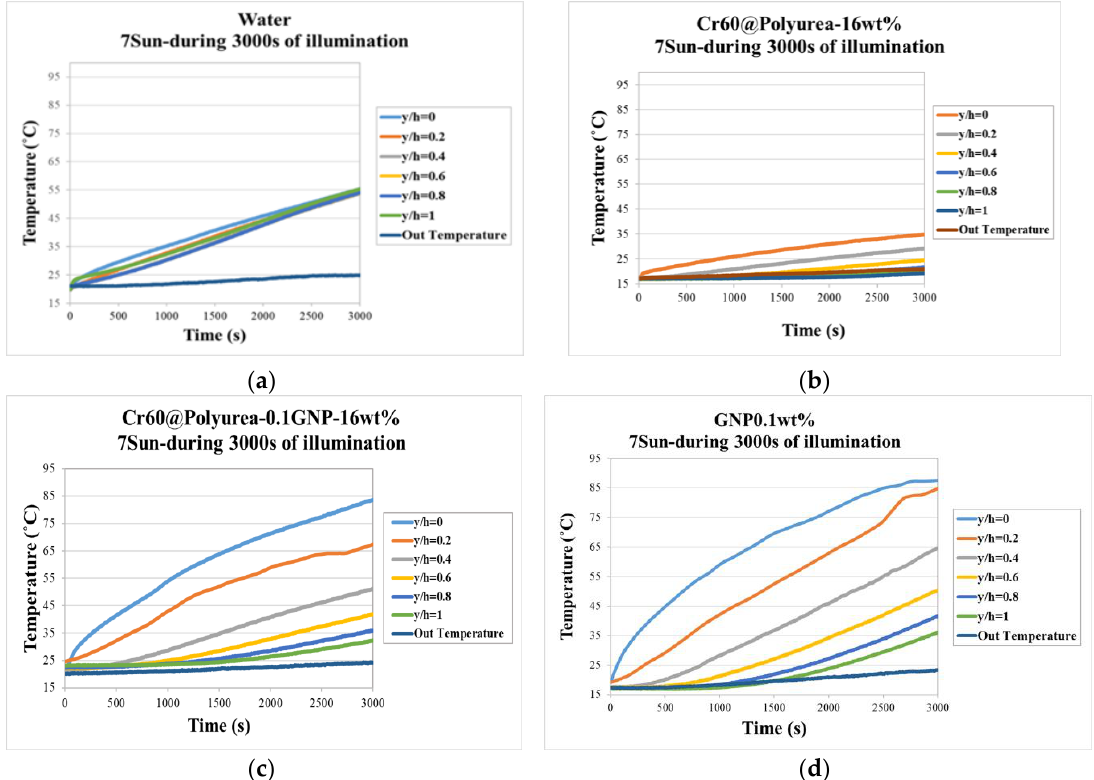
Figure 9. Photo-to-thermal conversion spectra of ( a ) water; ( b ) 0.1%GNP; ( c ) Cr60@Polyurea; and ( d ) Cr60@polyurea-0.1%GNP samples (h = the total height of the collector, y = the height distance from the illumination surface to the location of the adjusted thermocouple).